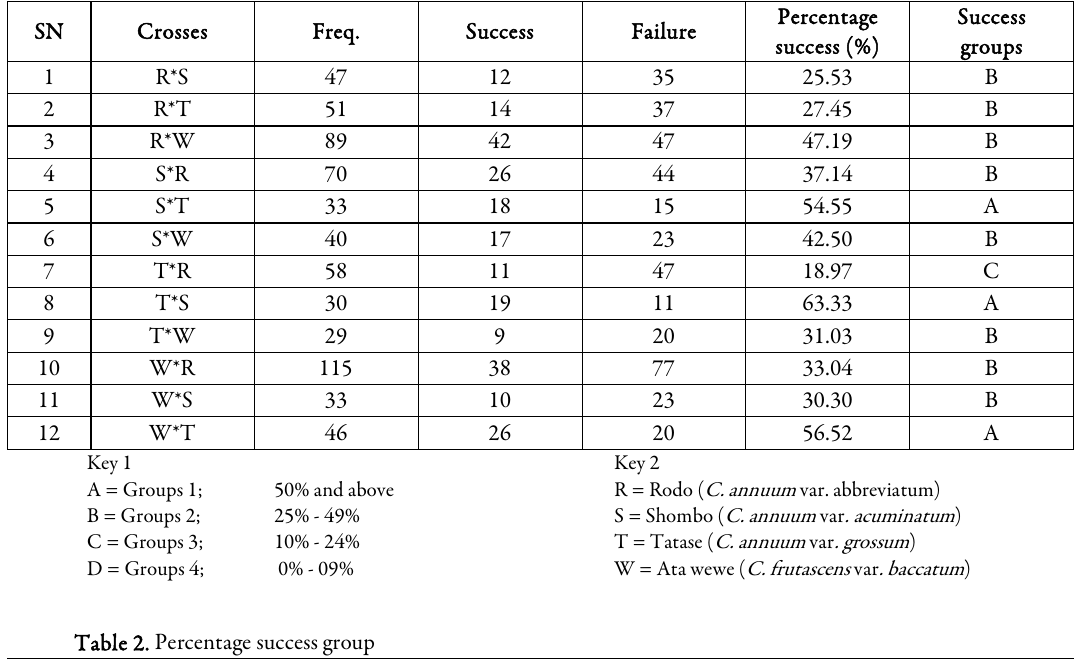
Table 1. Percentage cross pollination success among varieties of Capsicum sp.